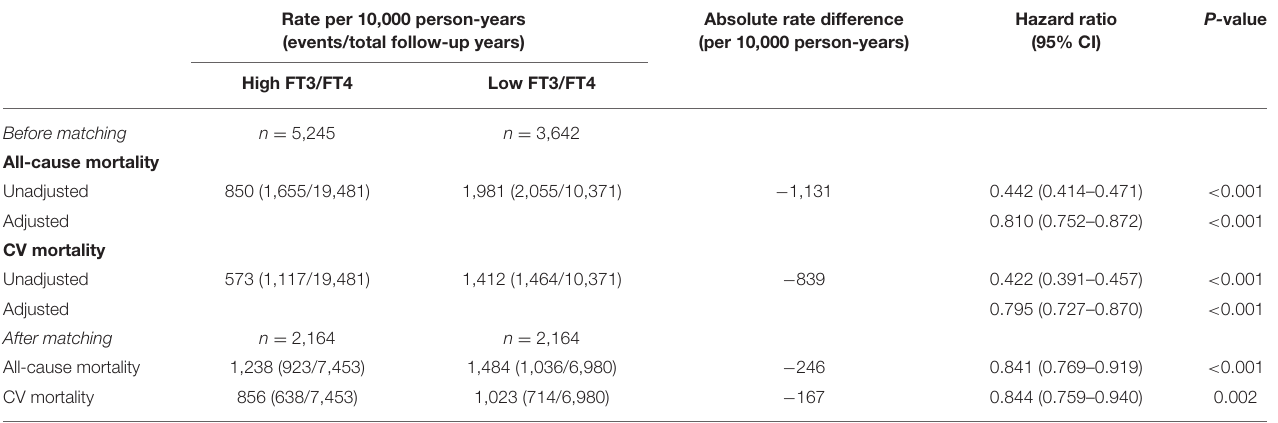
Absolute rate difference (per 10,000 person-years)